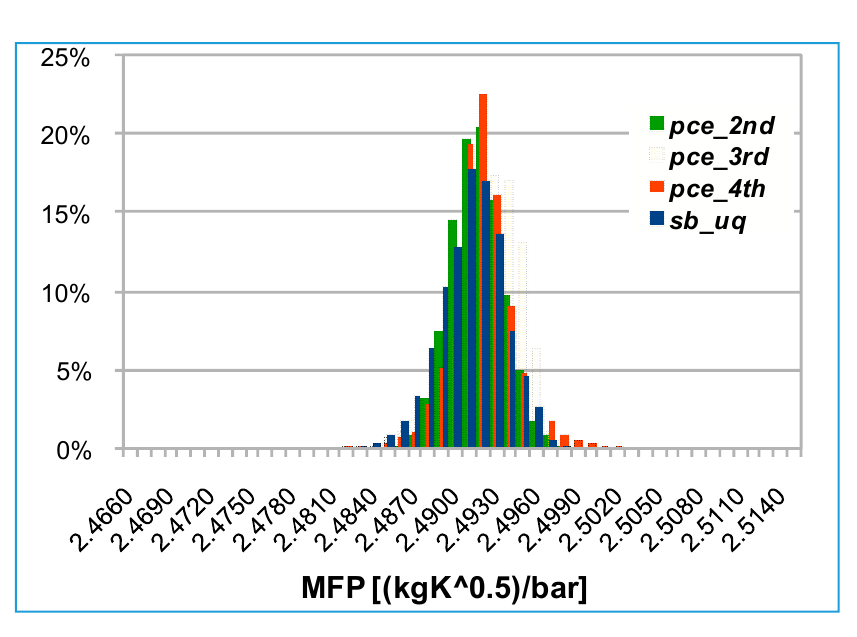
Figure 16. PCE vs. SB-UQ: mass flow parameter probability distributions coming from different polynomial orders. Table 9. Mass flow parameter maximum absolute probability di ff erences from SB-UQ